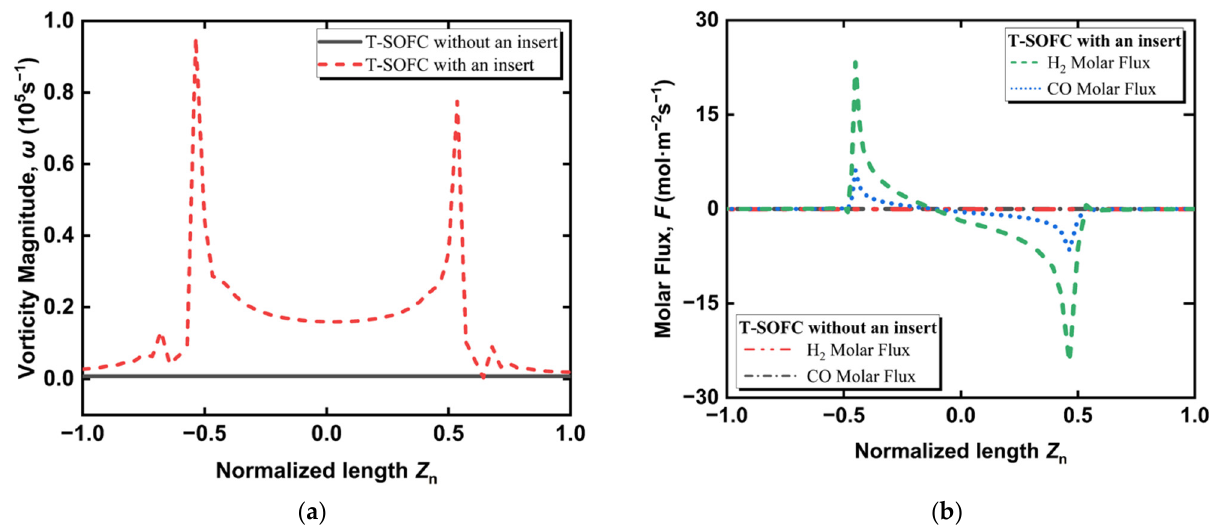
Figure 5. The axial distribution of ( a ) the vorticity magnitude and ( b ) normal molar fluxes of CO and H 2 at the anode/channel interface for tubular SOFCs with and without inserts.